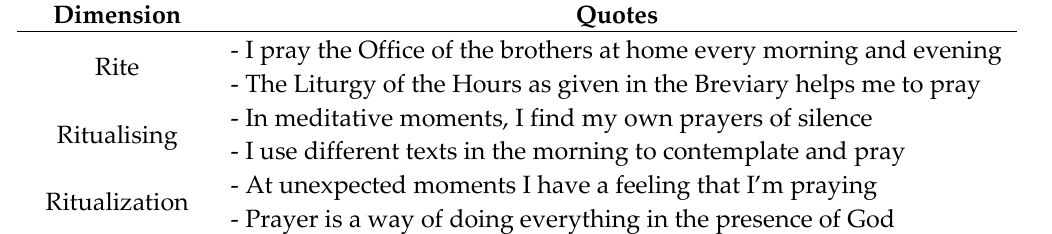
Figure 1. Dimensions of prayer—quotes.